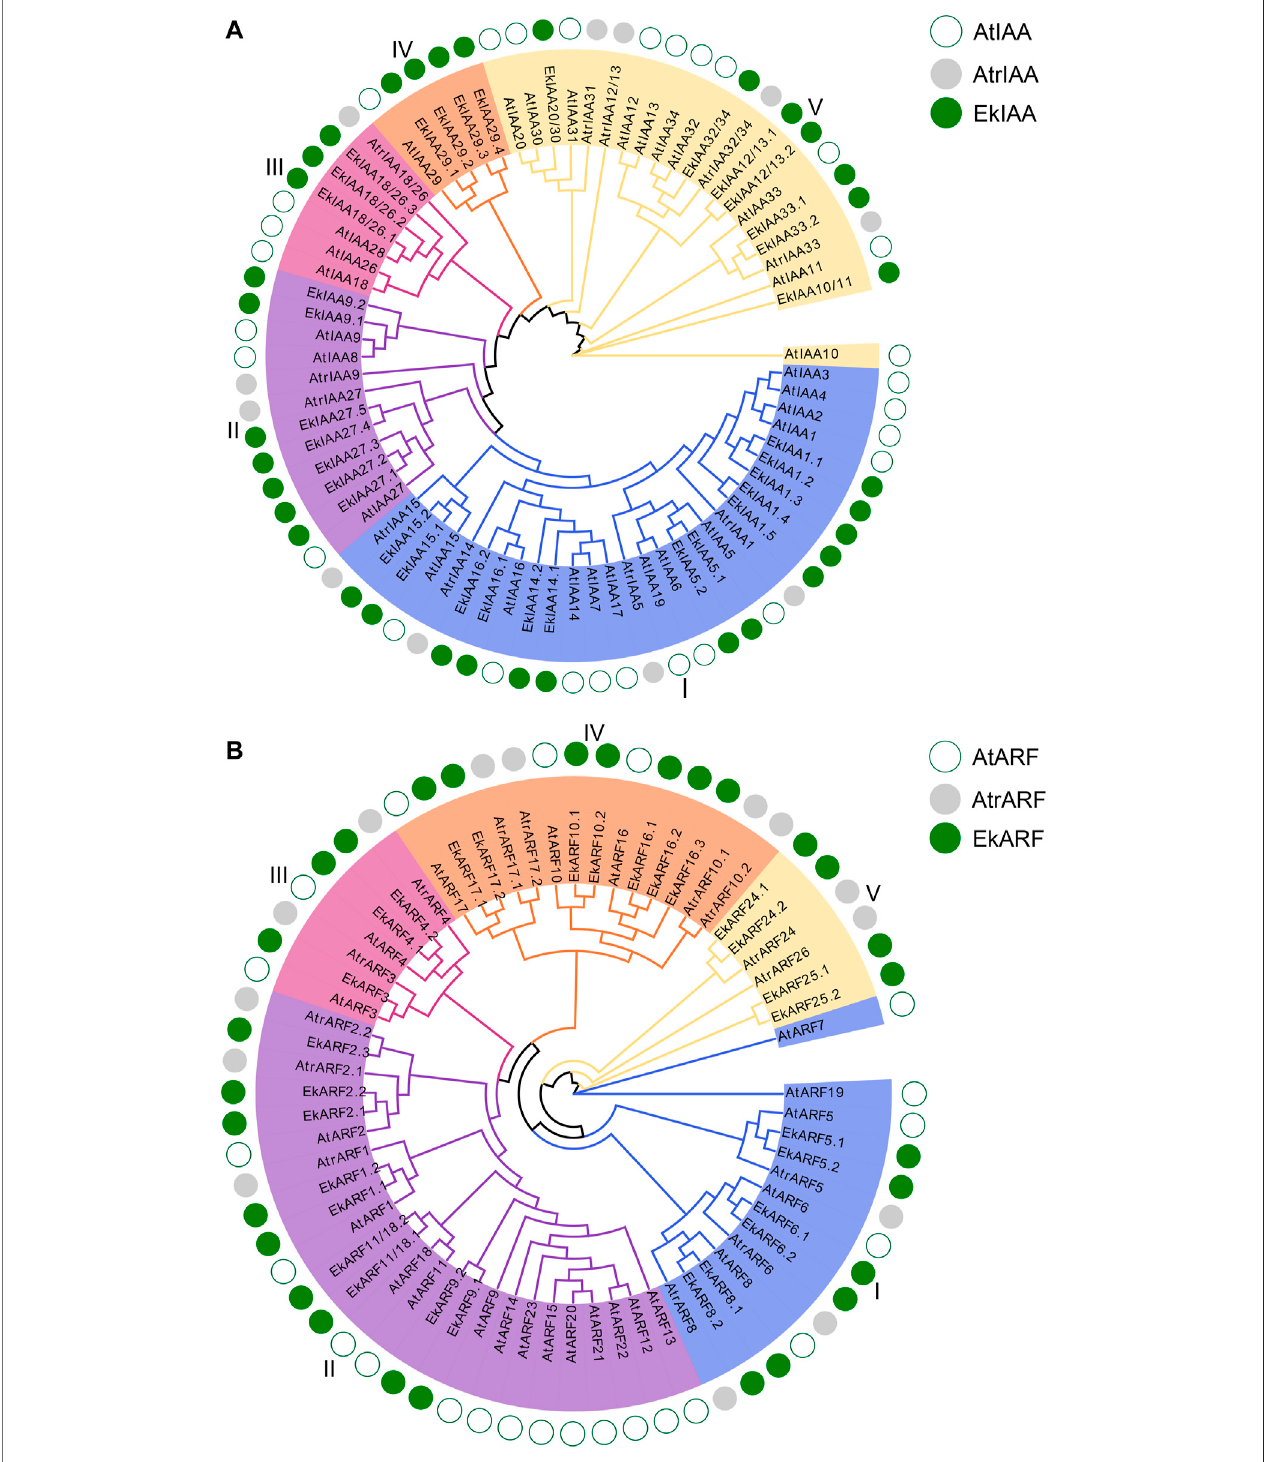
FIGURE 2 | Phylogenetic trees of EkIAAs (A) and EkARFs (B) from Arabidopsis, Amborella trichopoda , and E. konishii . Different groups have different colors. The green open circles, gray circles, and green solid circles represent Arabidopsis, A. trichopoda , and E. konishii , respectively.